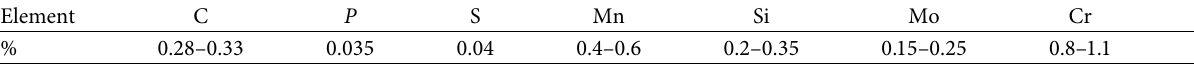
Table 1: Chemical analysis of steel alloy 4130 used in the present study a .